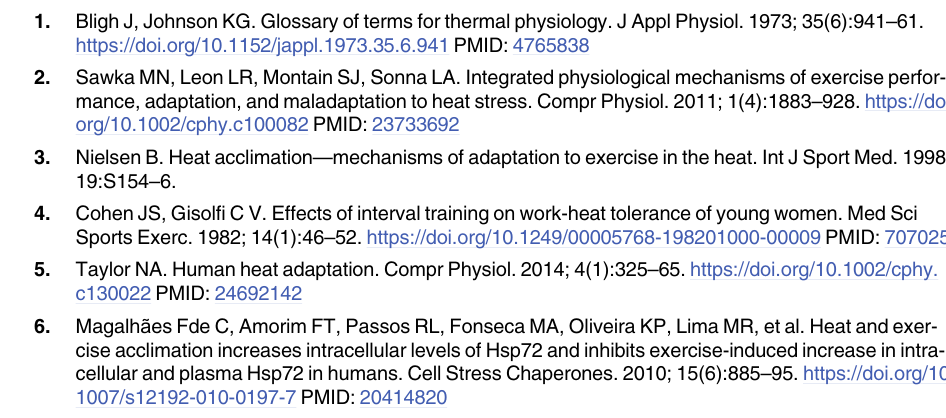
S8 Fig. Panel A—Ratio between the change in colonic temperature and the distance travelled (˚C/km) during the incremental exercises before and after the two-week interventions. Panel B—Change in the ratio between the change in colonic temperature and the distance travelled (˚C/km) between the incremental exercises before and after the two-week interventions.